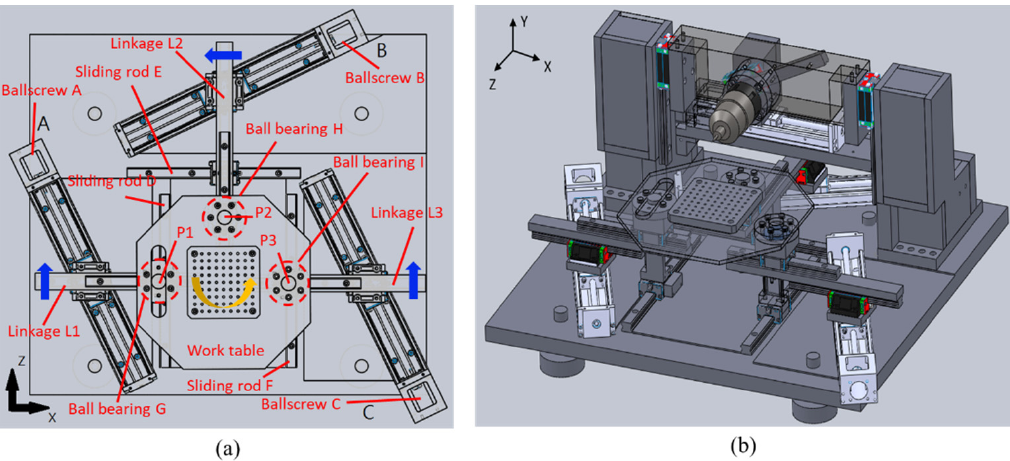
Figure 1. Scheme of co-plane platform, ( a ) X-, Z- and B-axis motion, ( b ) the micromachine tool. As shown in Figure 1, when the A and C ballscrews are fixed and the B ballscrew is moving, the linkage L2 pushes the table to move along the X direction. The linkages L1 and L3 and the sliding rod E provide the function of movement guidance. When the B ballscrew is fixed, the A and C ballscrews move in the same direction at the same speed, while linkages L1 and L3 move the table along the Z-axis, as shown in Figure 1. At this time, sliding rods D and F and linkage L2 provide the function of movement guidance. When ballscrews A, B, and C are moving in the same direction at the same speed (CW or CCW), the moving paths of the three connecting points (P1, P2, P3) are the distances from each connecting point to the center of the platform (as shown in Figure 1), which drives the platform for rotational movement about the center of the platform. The bearing on the sliding rod provides rotational DOF to rotate the platform around the center of the plat- form. This design provides 3 DOF movements (linear, moving along the X- and Z-axes, and rotation about the Y-axis) with a lighter inertia effect, and can also reduce the loading of the servo control system. Because the ballscrew drives operate using a tilt servo mecha- nism principle, the triangle geometric motion transformation will proportionally reduce the movement of the work table so that finer feed resolution can be achieved for the work table, and the errors caused by ballscrew backlash and pitch error can also be reduced. Because of the advantages mentioned above, the machine is able to achieve the high res- olution and high precision required for micromachining without the use of high-end driv- ing components or a CNC controller. Figure 2a shows the ballscrew using the tilt-servo mechanism principle. Tilt angle is the angle between the ballscrew and the sliding rod. When the ballscrew nut moves, the platform moves along the guidance rail (perpendicular to the connecting rod direction). The movement of the platform will be reduced by a small proportion due to triangle geo- metric motion transformation. When the tilt angle is fixed, the travel distance, feed, and feed resolution of the platform can be consistently converted based on the triangle geom- etry principle. Figure 2b shows the spindle seat using the tilt-servo mechanism. Two sliding rails (K, M) are used for the Y-axis, and the sliding rail (N) is mounted on the spindle seat. The ballscrew and sliding rail N are connected by means of fixed link L4. When the ballscrew drives the ballscrew nut, the spindle seat will be moving along the Y-axis. The smaller tilt angle is able to produce higher feed resolution, but the spindle seat travel range becomes smaller, i.e., the travel range is smaller. Conversely, larger tilt angles result in lower feed resolution, but larger travel range of the spindle seat. The prototype of the micromachine tool with multi-DOF with horizontal co-plane has 4 DOF, including linear movement in the X, Y, and Z directions, as well as B-axis rotation.